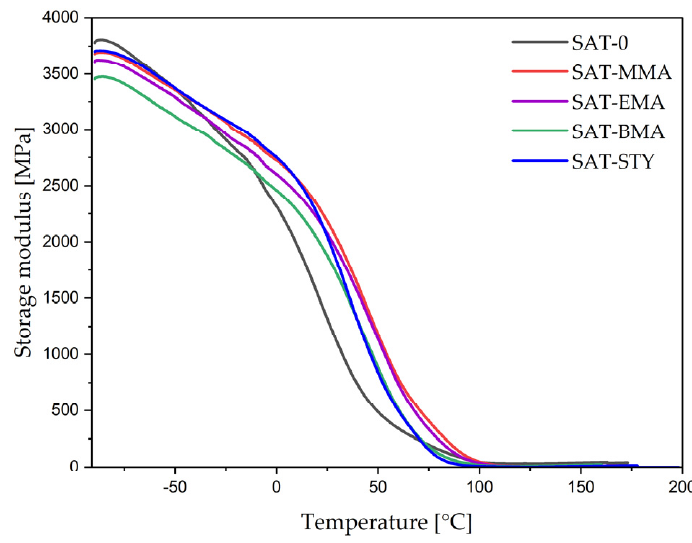
Figure 10. Storage modulus (E ′ ) of thermally cured SATs.